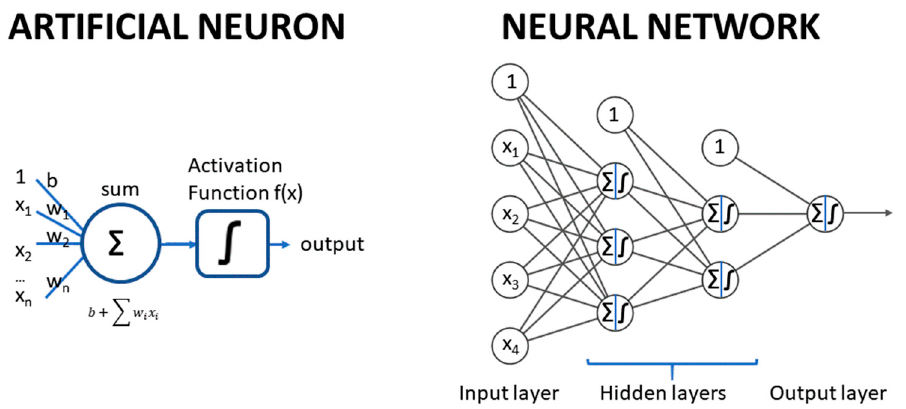
Figure 5. Typical structure of an artificial neuron and a fully connected feedforward neural network. The x i are the predictor variables, the w i are the weights and b is the biass.